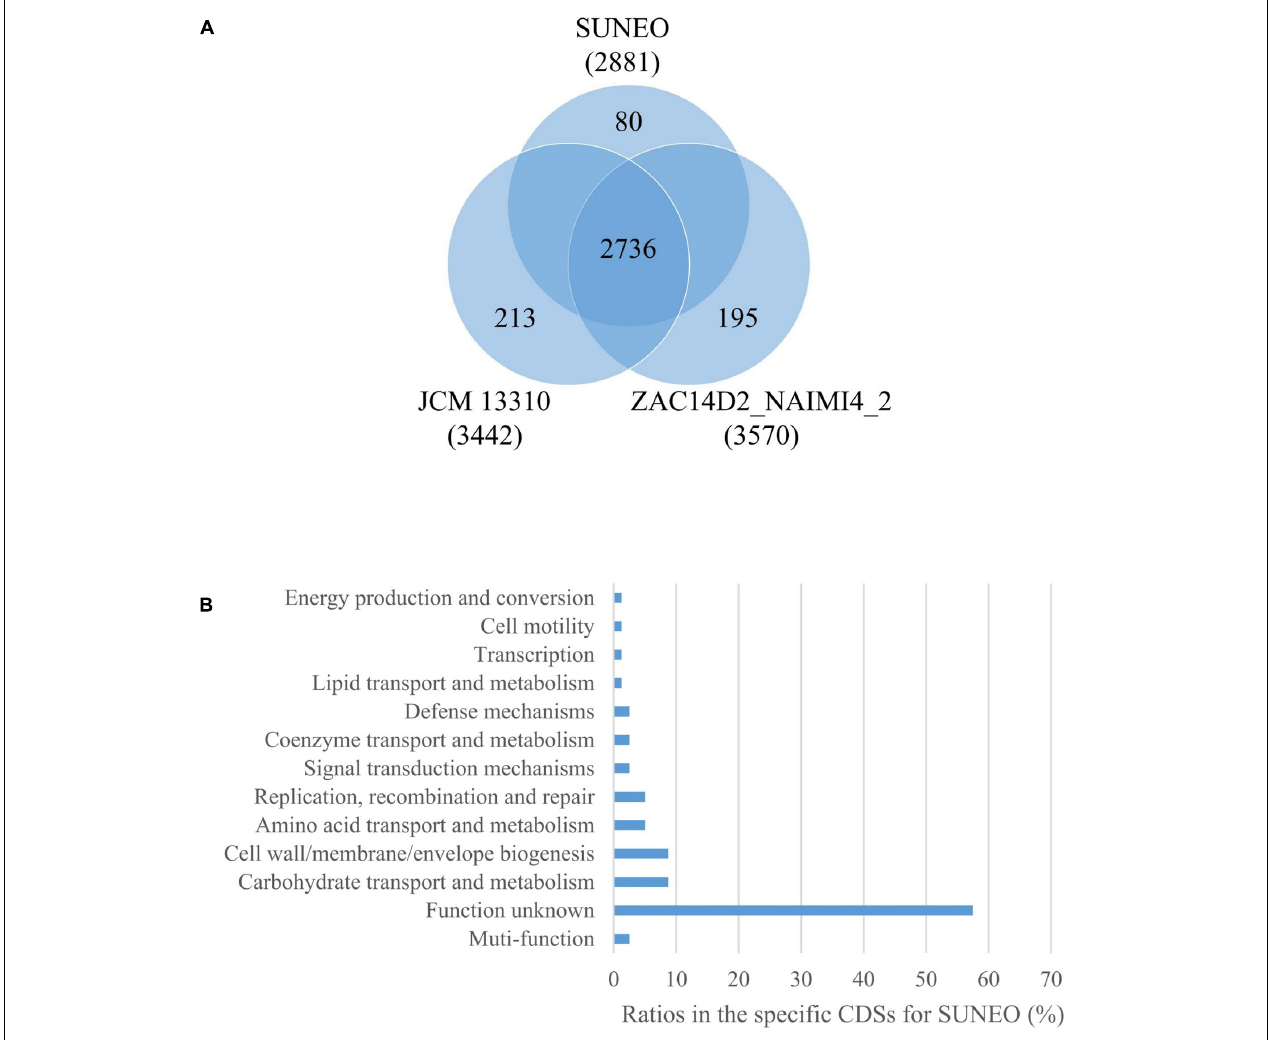
FIGURE 3 | Comparison of the gene contents among Stenotrophomonas acidaminiphila strain SUNEO, JCM 13310, and ZAC14D2_NAIMI4_2. (A) Partial Venn diagram showing the numbers of shared (core) and strain-specific CDSs. (B) Diagram showing the COG category-based functional analysis of SUNEO-specific